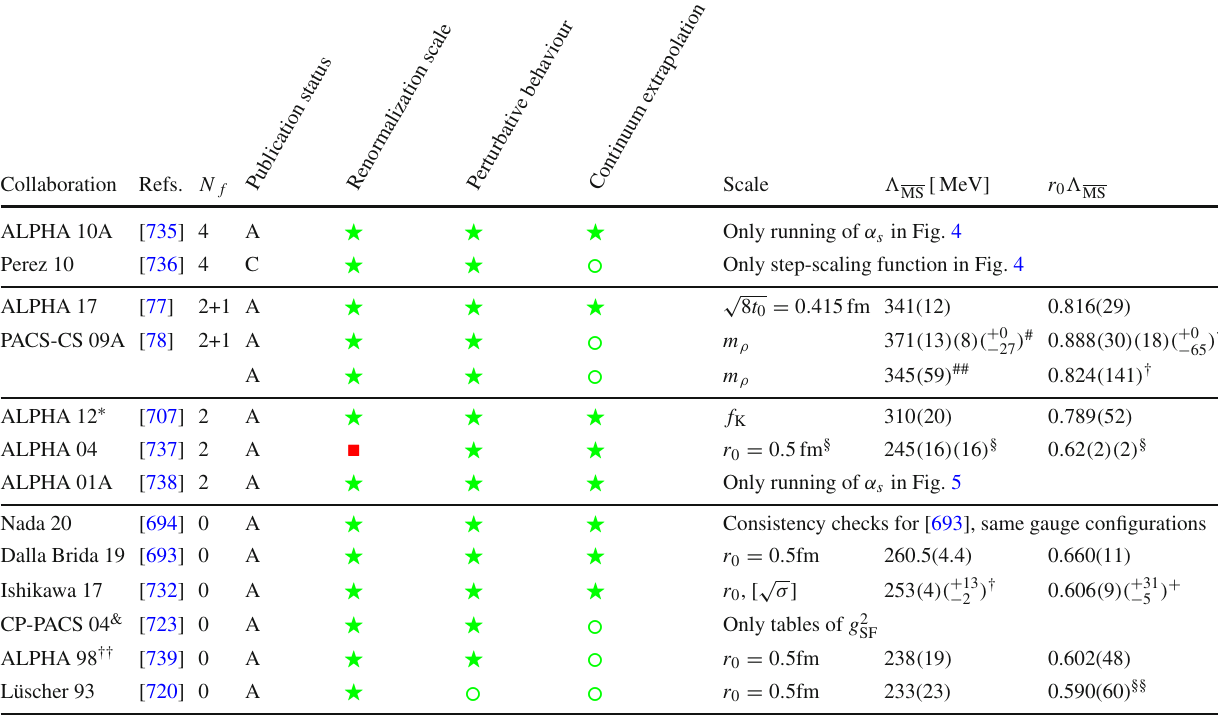
Table 60 Results for the (cid:8) parameter from computations using step-scaling of the SF-coupling. Entries without values for (cid:8) computed the running and established perturbative behaviour at large